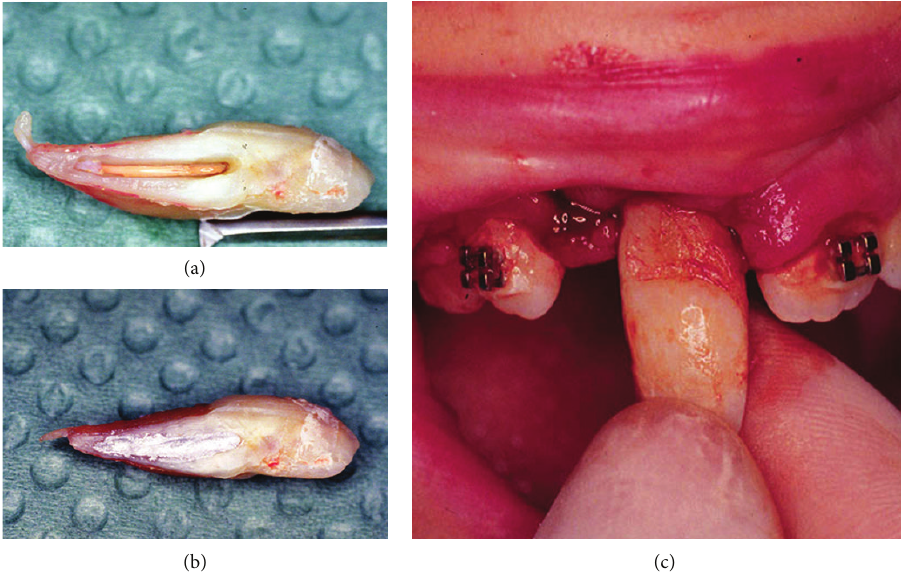
Figure 3: Intraoperative images. (a) After extraction, hemisection was performed. (b) Gutta-percha exposure was filled with silver amalgam. (c) The tooth’s remaining portion was then replanted into the socket.